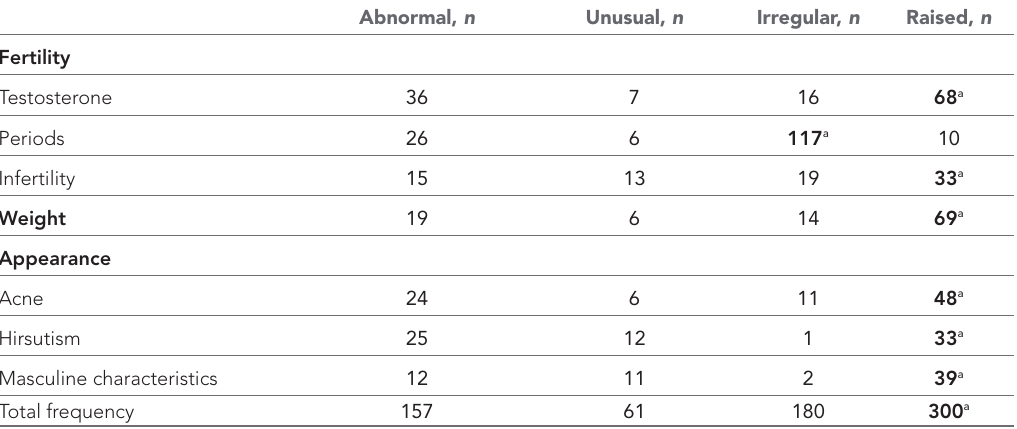
Table 3 Describing the consultation language used during diagnosis: framing of the problem Abnormal, n Unusual, n Irregular, n Fertility